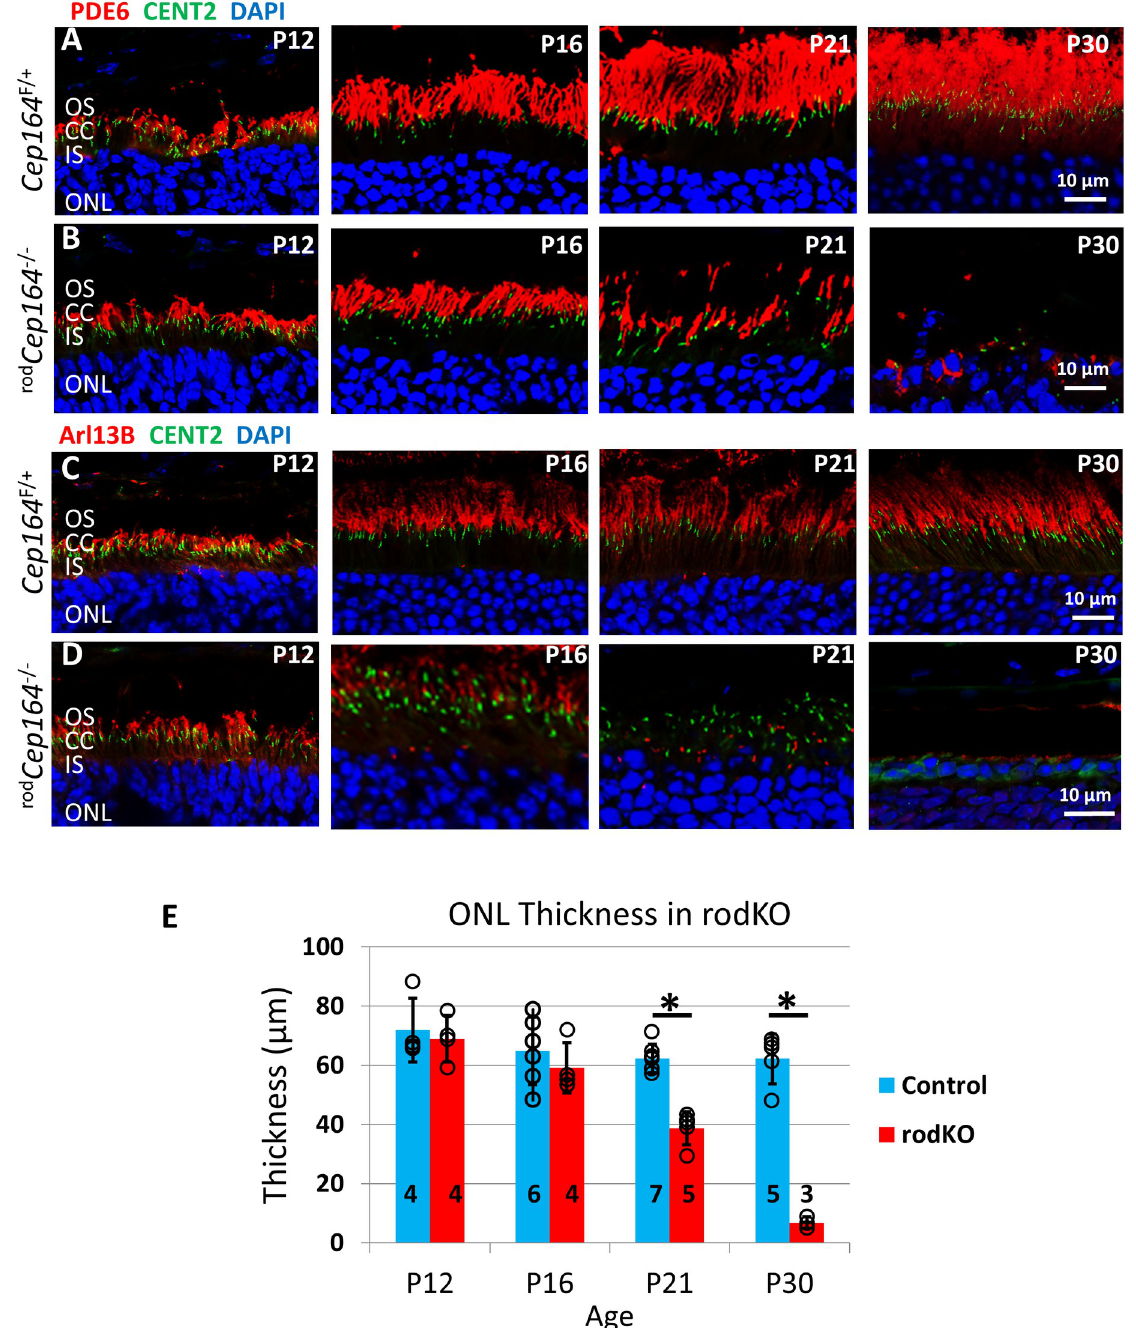
Fig 3. rod Cep164 -/- OSs degenerate after P16. Rows A, B, Cep164 F/+ (A) and Cep164 F/F ;iCre75 ( rod Cep164 -/- ) retina cryosections (B) probed with PDE6 antibody (MOE, red) (A, B) at P12, P16, P21 and P30. All sections are on Egfp-Cetn2 background to mark the position of centrioles and CC. Note disintegrating rod Cep164 -/- OSs in B at P21 where CC (green) is still congruent with the OS (red). Rows C, D , central Cep164 +/F (C) and central rod Cep164 -/- (D) retina cryosections probed with anti-ARL13B (red) at P16, P21 and P30. Note ARL13B, known to interact with CEP164, does not reach the OS in the absence of CEP164. E , ONL thickness at P12, P16, P21 and P30 in central retina of rod Cep164 -/- (n = 3–7). ONL thickness is indistinguishable at P12 and P16, but decreases rapidly after P16. � p < 0.05, t -test.